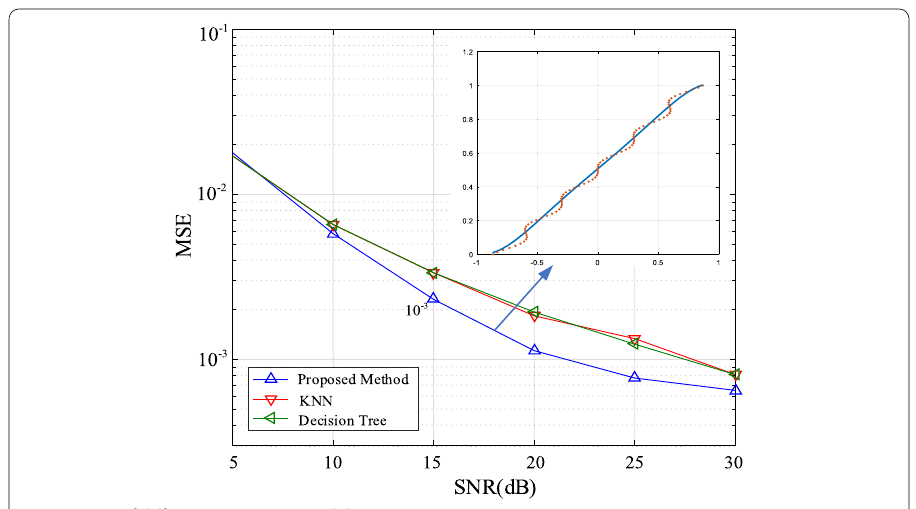
Fig. 9 MSE of different regression